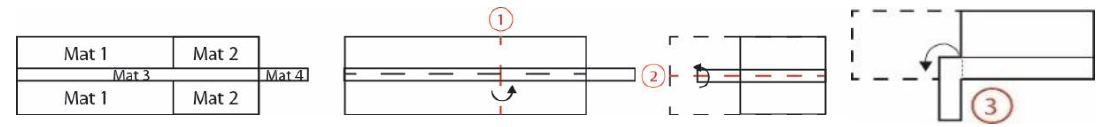
Figure 10. Sequence of crossfolding for method 1.